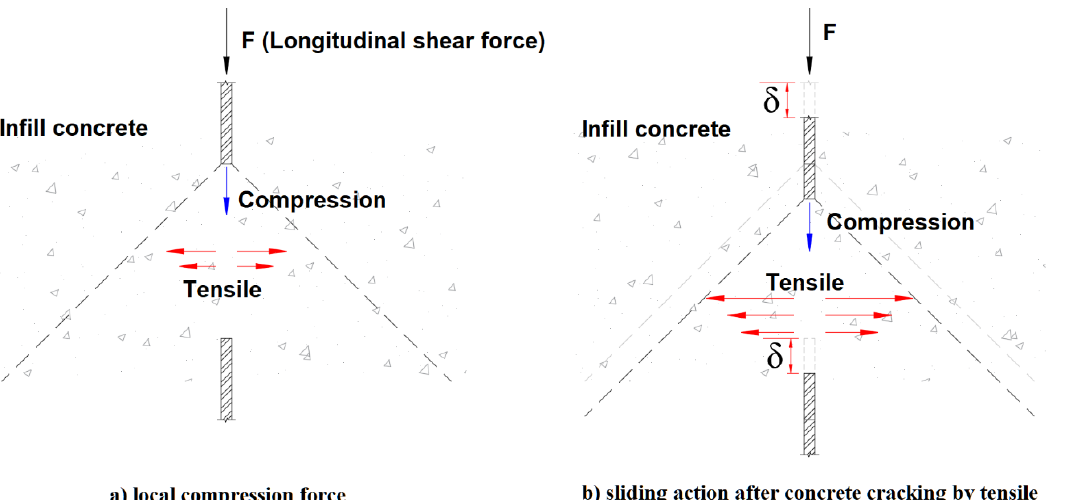
Fig. 4: Mechanism of transferring longitudinal force in shear connection – (a) Local compression force; (b) sliding action after concrete cracking by